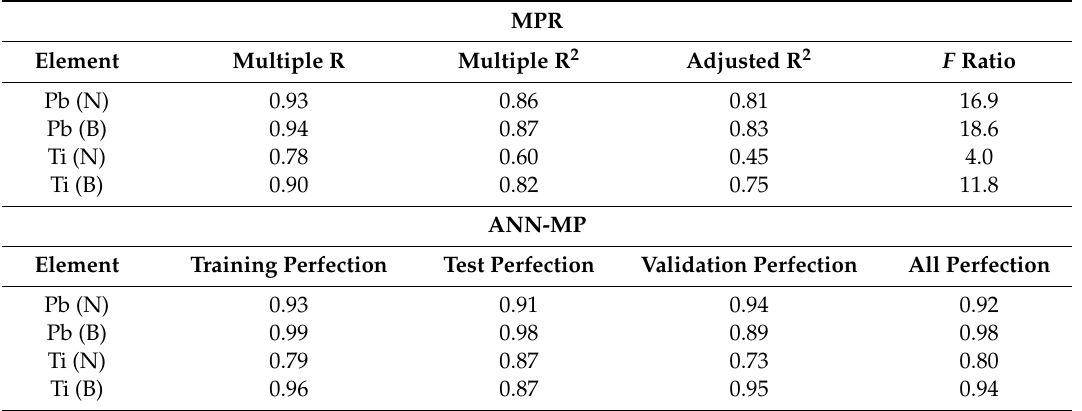
Table 2. Model quality of MPR and